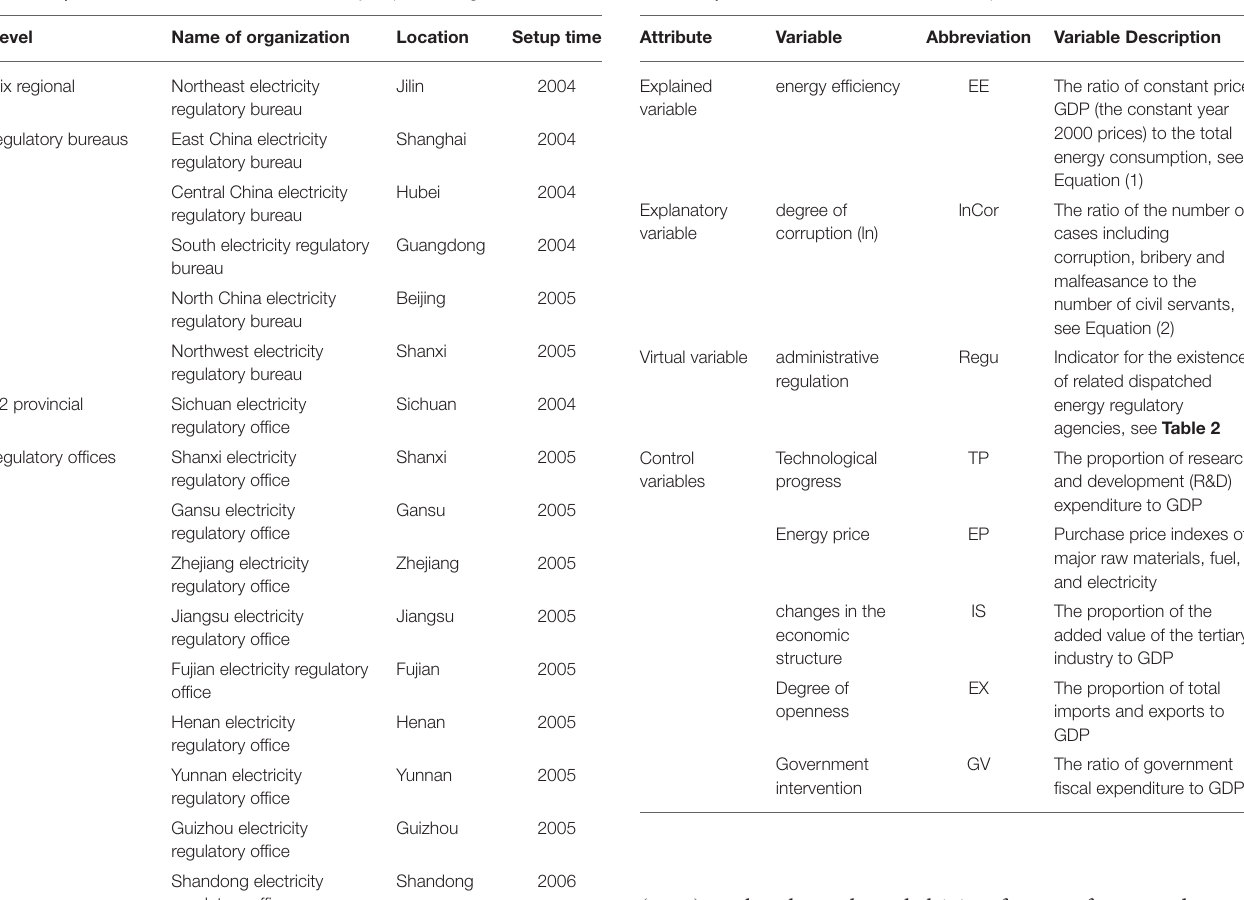
TABLE 3 | Selected variables and their brief